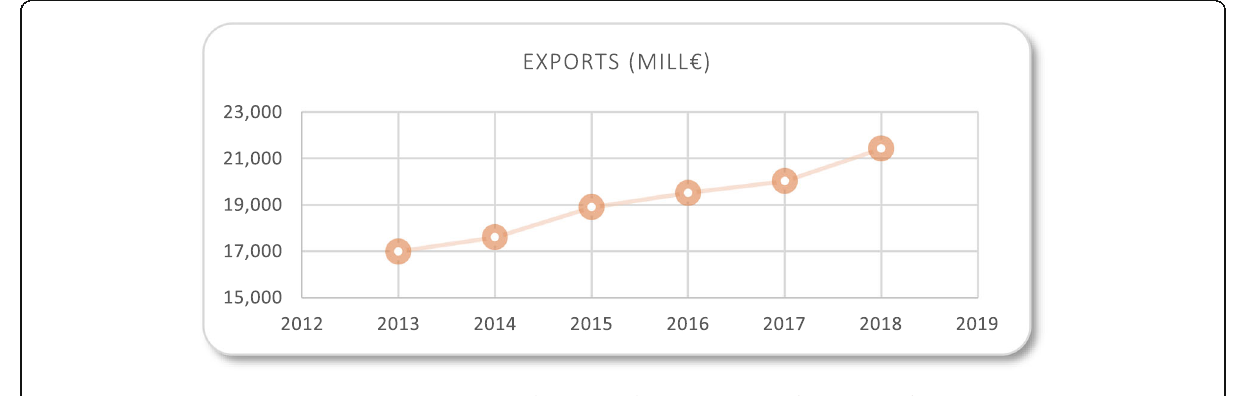
Fig. 8 The exports of the Spanish equipment